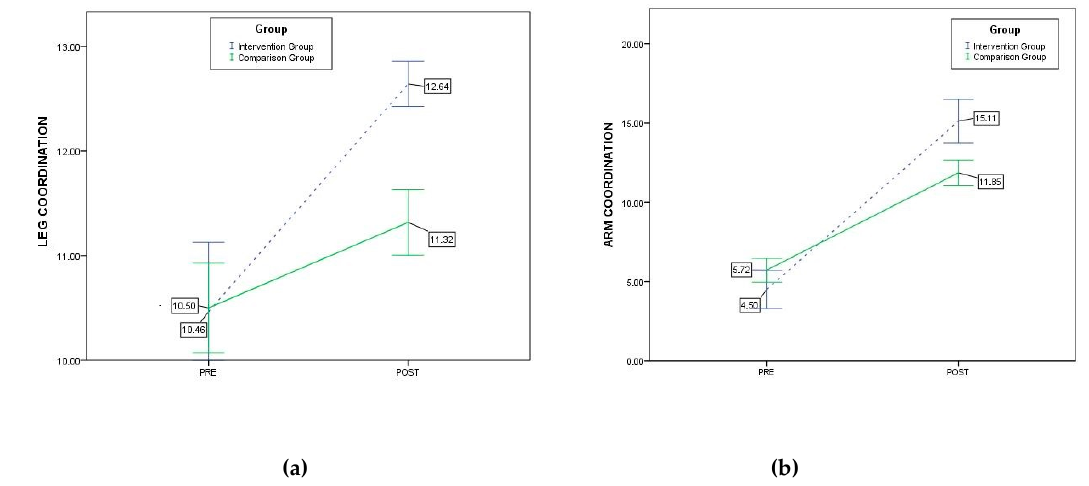
Figure 2. Evolution of leg coordination ( a ) and arm coordination ( b ) related to the intervention and comparison groups.